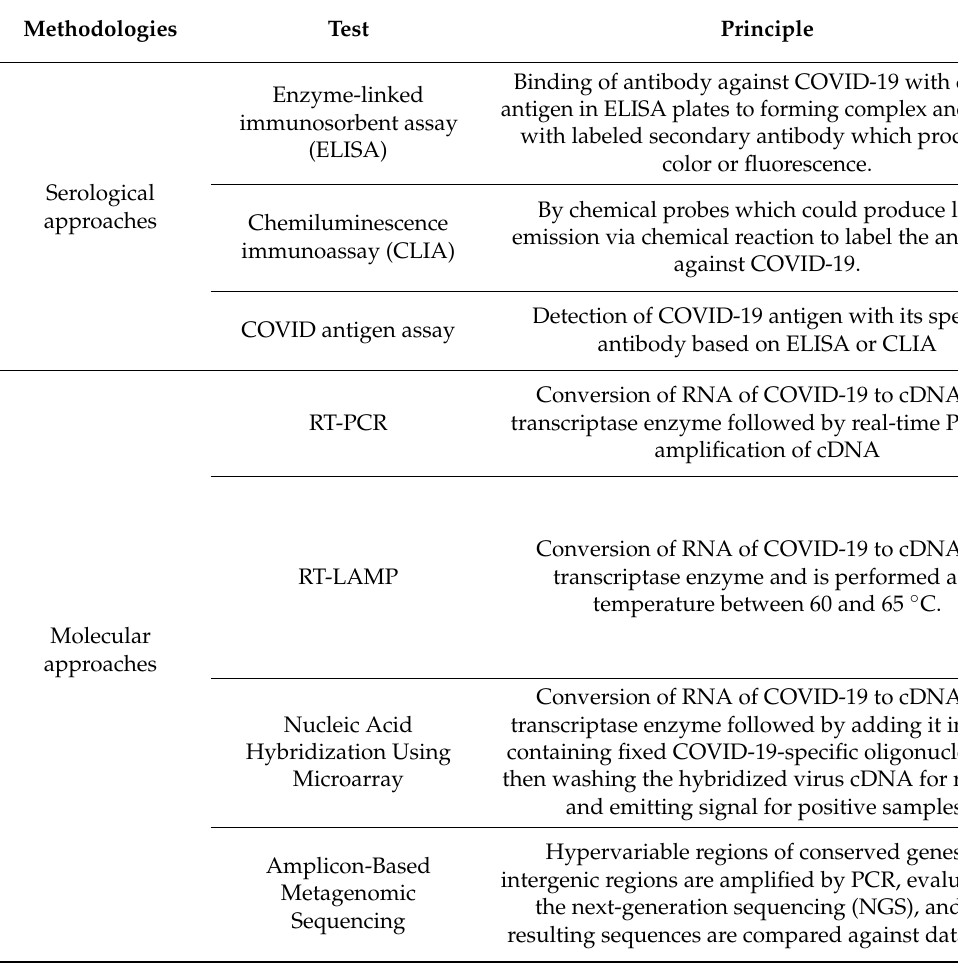
Table 1. A summary table with all the methodologies, their principle, needed samples, cost, advantages, and massive used